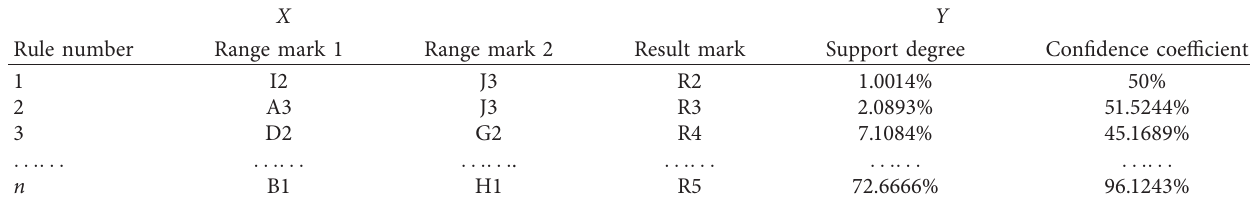
Table 5: Fitting results for the bike-sharing association rule Model 1 ( X ➡ Y